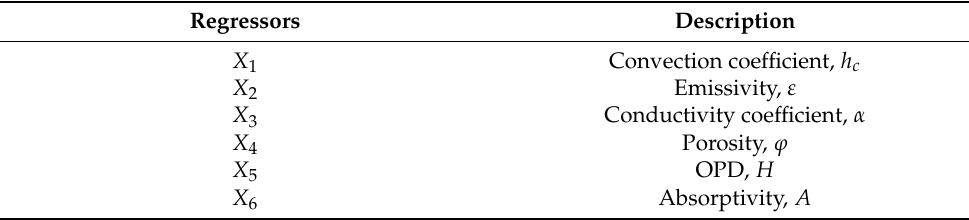
Table A2. Description of regressors for the thermal analysis parameters in Table